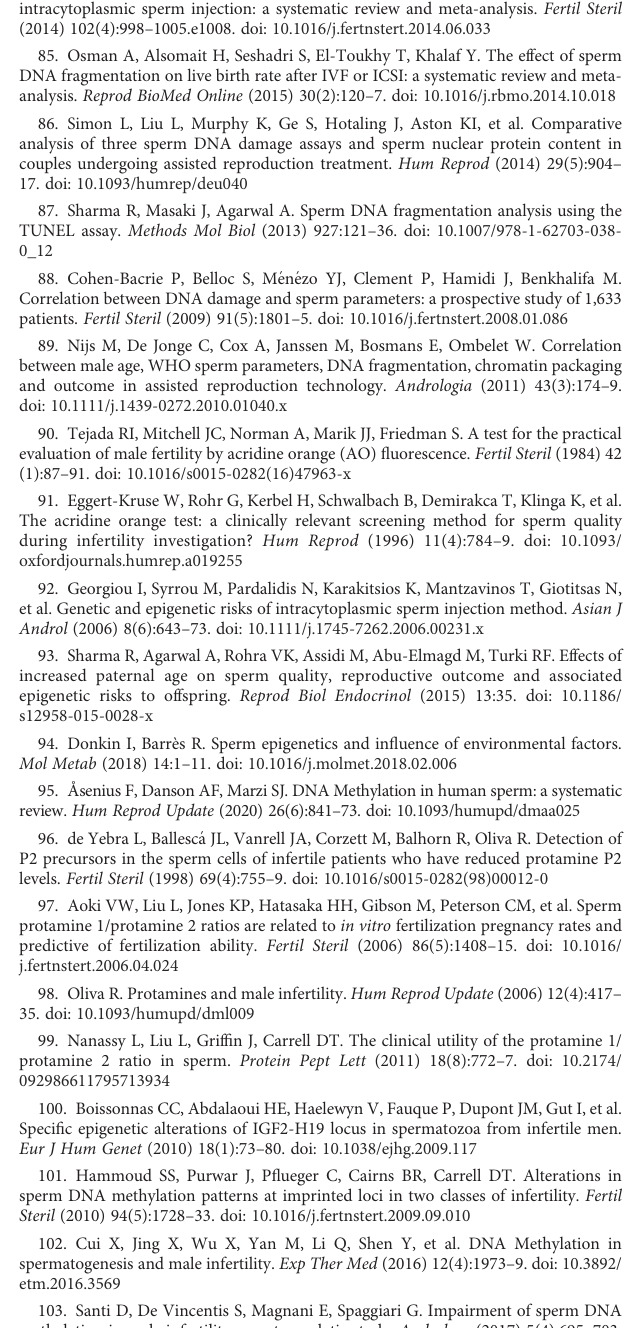
selection of sperm for intracytoplasmic sperm injection. Curr Opin Obstet Gynecol (2006) 18(3):260 – 7. doi: